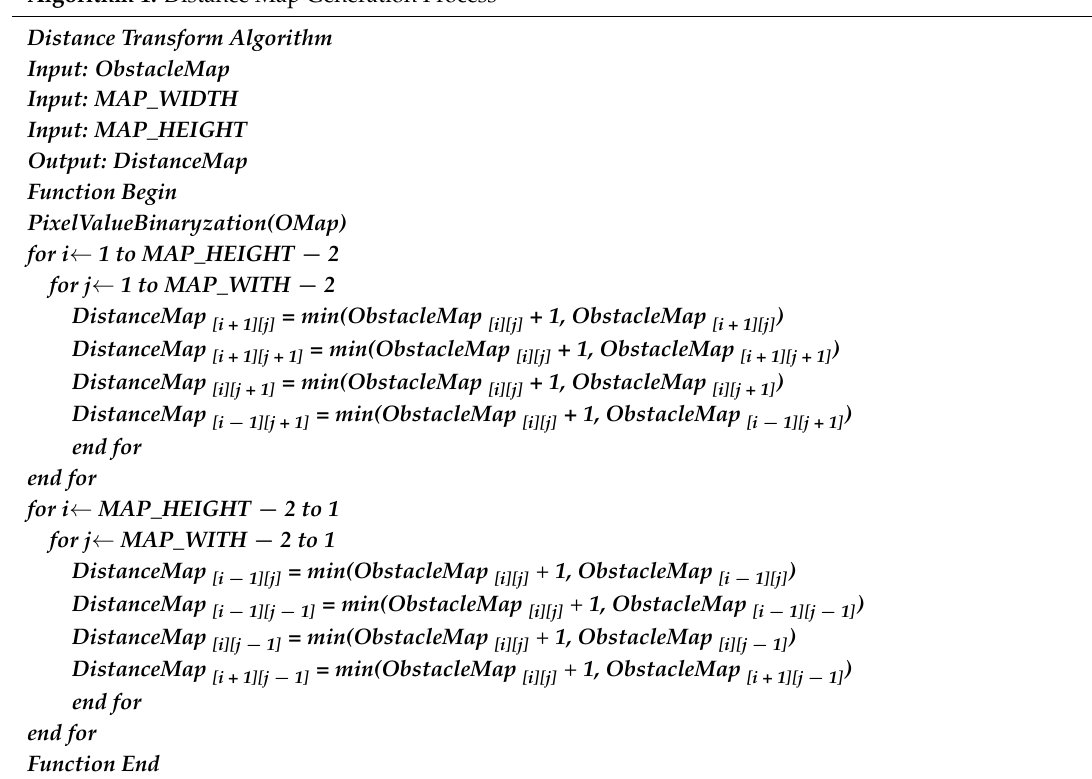
Algorithm 1. Distance Map Generation Process Distance Transform Algorithm